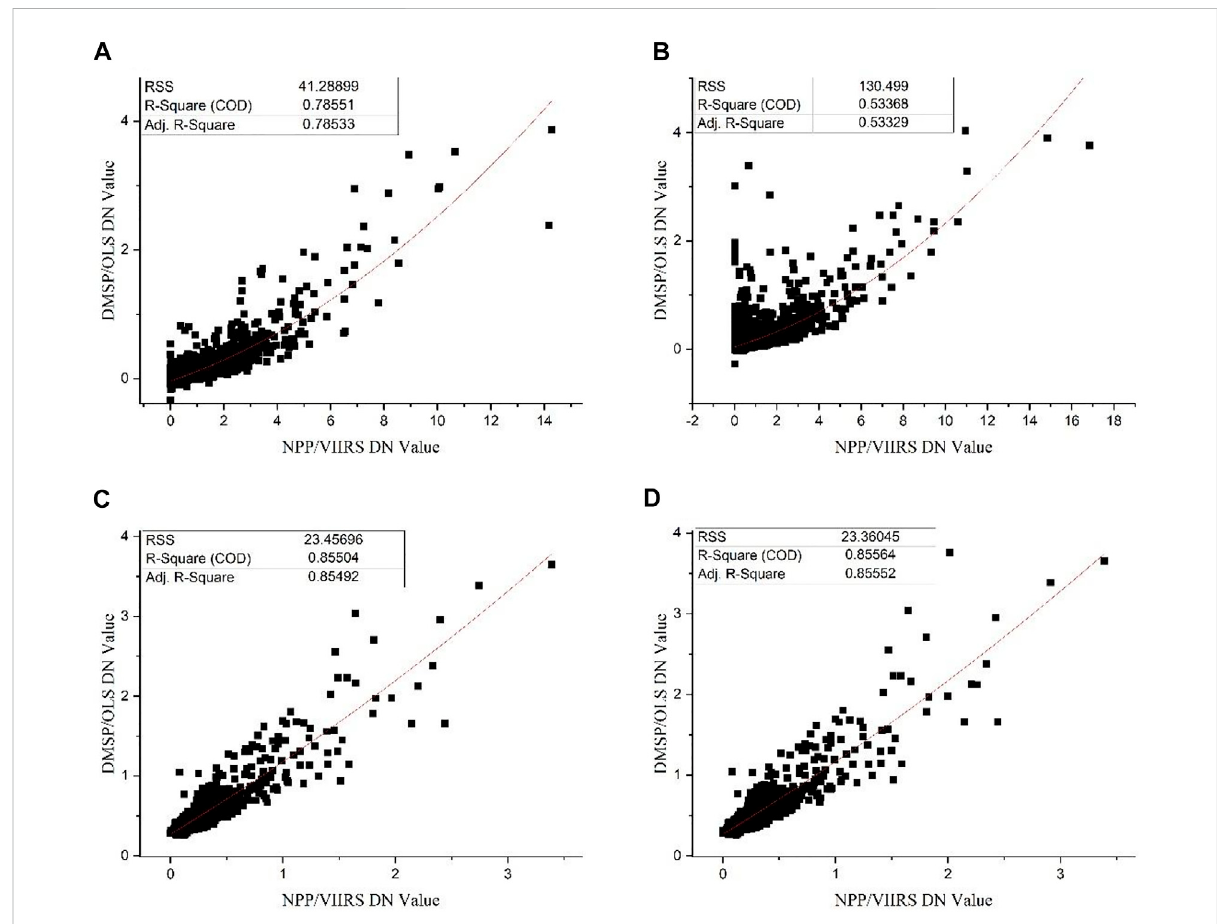
FIGURE 5 Comparisonofdataintegrationeffectsin2012and2013. (A) and (B) aretherawDMSPandNPPlightingdata fi tsin2012and2013; (C) and (D) are the processed DMSP and NPP lighting data fi ts in 2012 and